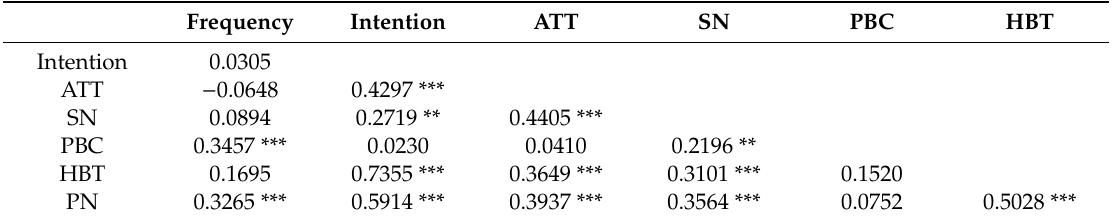
Table A4. Correlation between TPB constructs, perceived need, and habit for dairy consumption ( n = 85). Frequency